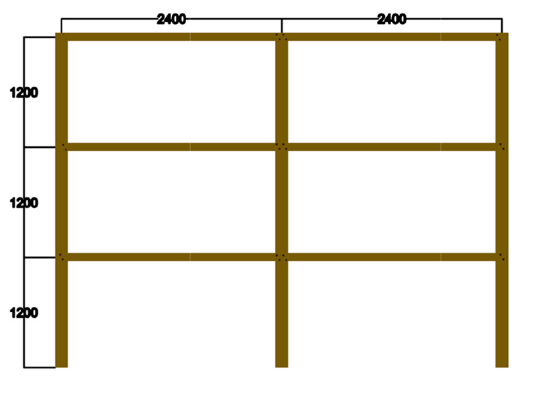
Figure 1. Post arrangement of a 2-section system. This arrangement can be continued to include as many sections as desired.